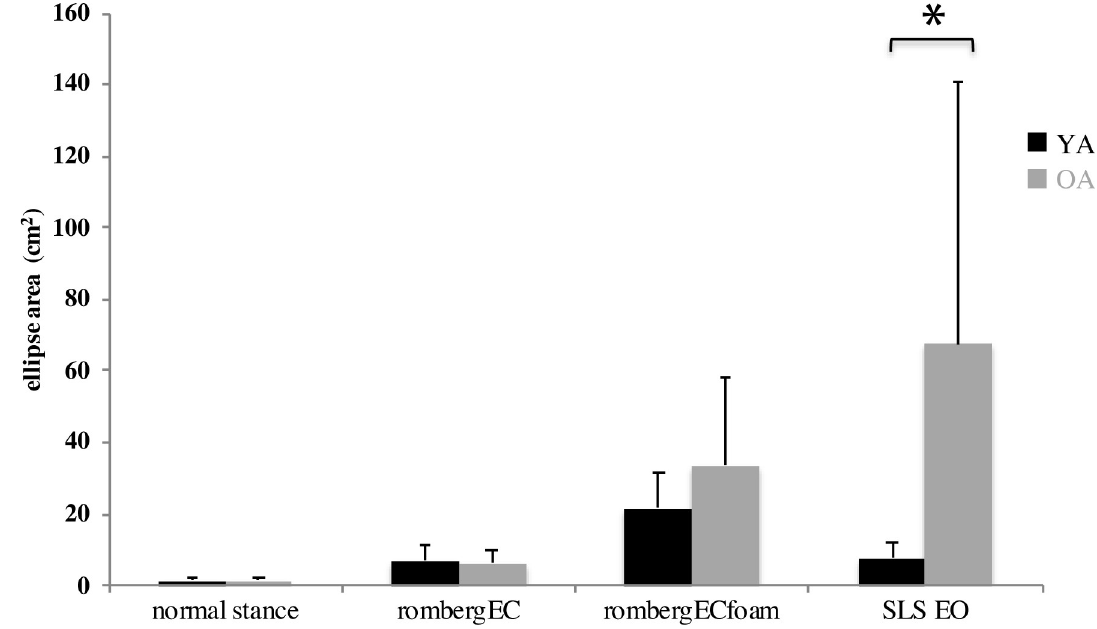
Fig 1. Performance of young (black bars) and older (gray bars) adults in four balance tasks with different degrees of difficulty. Task difficulty increases from left to right. Smaller ellipse area reflects less body sway (i.e. better balance). Error bars represent standard error. EO: Eyes Open, EC: Eyes Closed, SLS: Single Leg Stance. N = 12 Young, 14 Old.